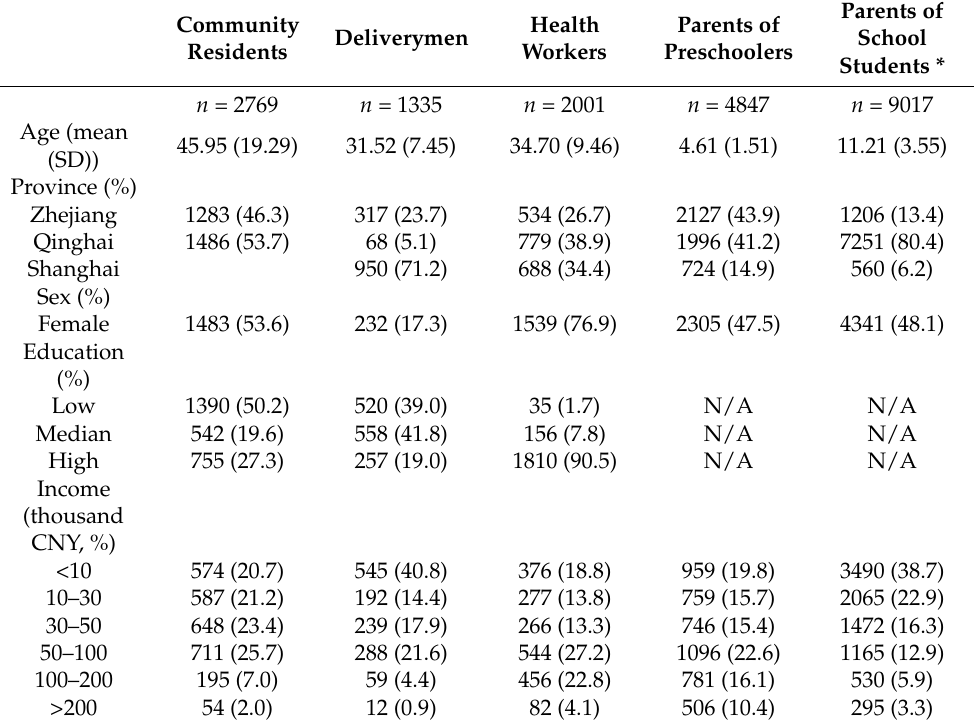
Table 1. Description of the